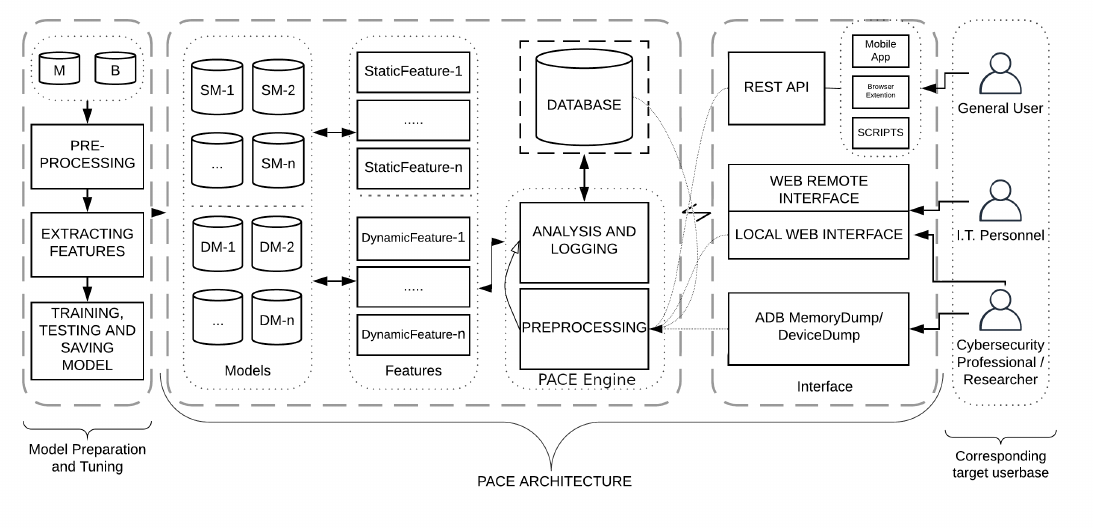
Figure 4. Workflow and Architecture of PACE. [M-Malware; B-Benign; SM-Static Model; DM-Dynamic Model].